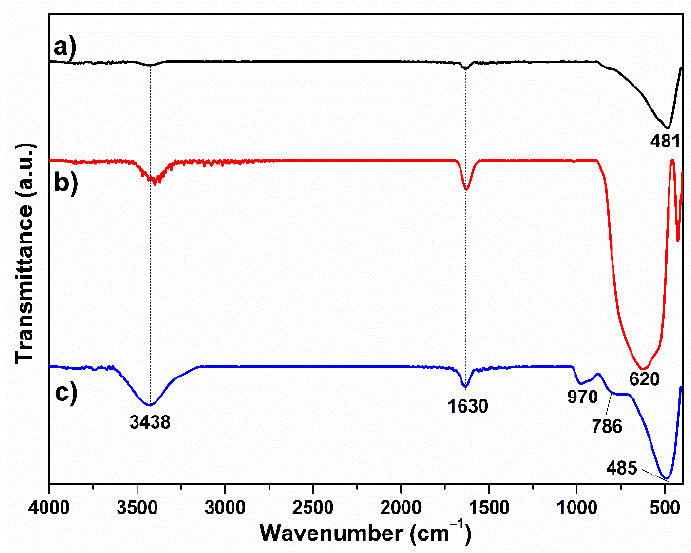
Figure 5. FTIR spectra of ( a ) TiO 2 _NP, ( b ) TiO 2 _LS1, and ( c ) TiO 2 _LS2. From the diffuse reflectance spectra, presented in Figure 6, the optical direct band gaps of the TiO 2 photoelectrode materials were estimated by using the Tauc plot [23], and intercepting the extrapolated linear fit for the plotted experimental data of ( α h ν ) 2 versus incident photon energy (h ν ) near the absorption edge. The obtained values of 3.12 eV and 3.09 eV for TiO 2 _NP and TiO 2 _LS1, respectively, are comparable to the data reported in the literature for anatase and rutile polymorphs of TiO 2 structures [24]. The value of 3.36 eV obtained for the TiO 2 _LS2 sample is much higher than previously reported values of mixed anatase-rutile TiO 2 nanoparticles [25]. In general, the value of Eg of a mixed TiO 2 nanoparticles with rutile and anatase structures decreases continuously with the increase in rutile content. In the case of TiO 2 _LS2, a significant increase in the band gap was highlighted and could be correlated with the presence of the surface titanium hydroperoxo species revelated by FTIR spectra. The UV-Vis spectrum of curcumin in ethyl acetate solution showed a broad absorption at around 300–450 nm with a maximum absorption band at a wavelength of 416 nm attributed to the electronic transitions n → π *, and a weak absorption band at 251 nm to the electronic transitions π → π *, respectively. The groups responsible for the absorption of the dye are the carbonyl groups in the structure of curcumin and the accumulation of groups grafted on the aromatic nucleus producing a bathochrome shift. The DN-F01 dye is similarly characterized by a broad absorption at around 350–480 nm with a maximum absorption band at a wavelength of 421 nm (Figure